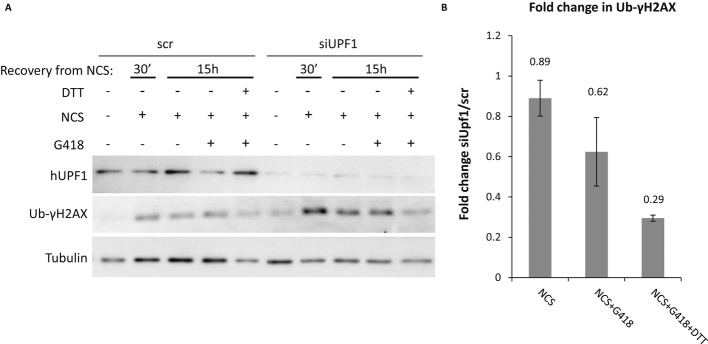
NMD inhibition together with UPR activation enhances the response to readthrough treatment.P133 cells were transfected with siRNA against hUPF1 or nonspecific control siRNA (scr) for 72 h. DTT, G418, and NCS treatments were performed as described in Fig 3A.A Protein extracts were prepared and analyzed by immunoblotting with anti-hUPF1, anti-γH2AX, and anti-tubulin antibodies.B Quantification of Ub-γH2AX levels normalized to tubulin. All siUPF1 samples were normalized according to the nontreated siUPF1. Data represent the fold change of Ub-γH2AX in siUPF1 compared to scr, for each indicated treatment. Quantification is an average of two experiments.